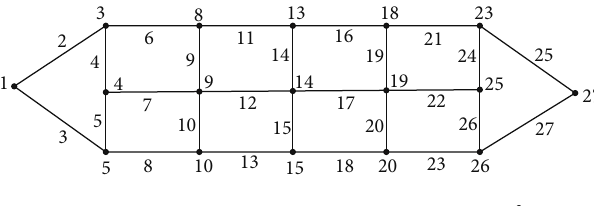
Figure 8: A C -exponential mean labeling of DA 2